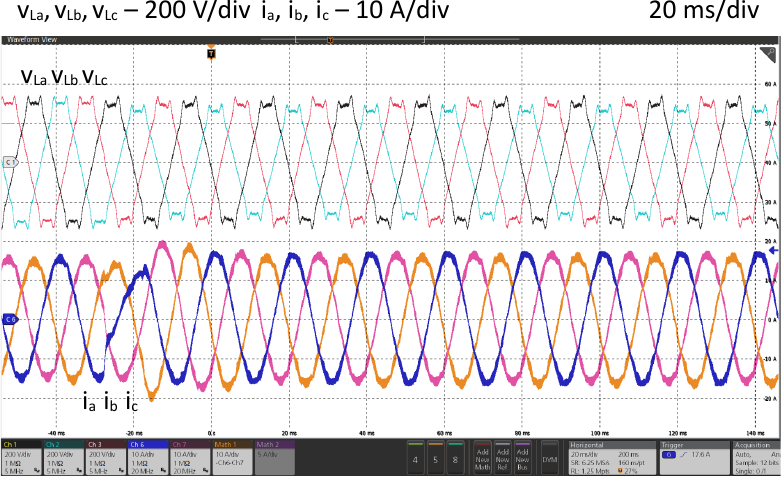
Figure 19. Experimental result of a transient state between symmetrical and asymmetrical grid